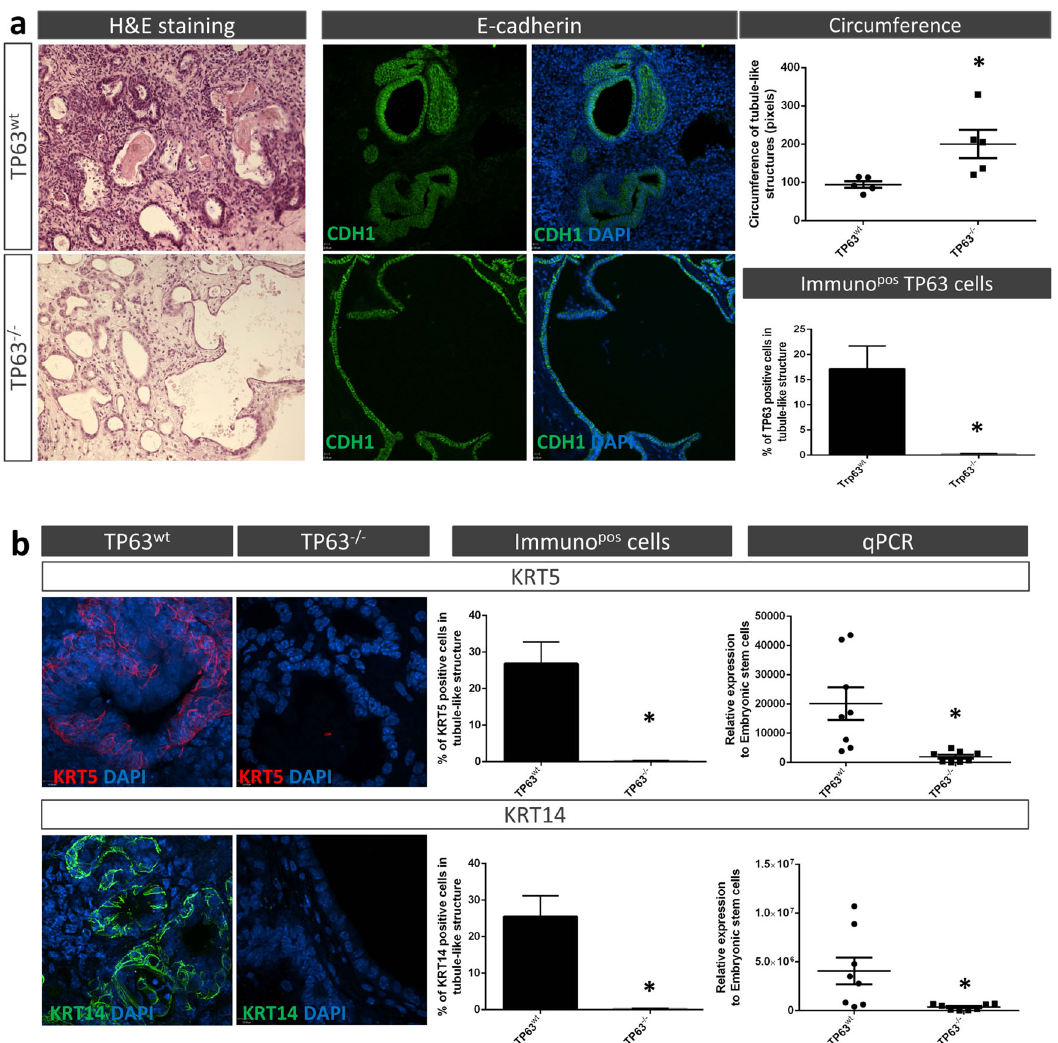
Fig. 4 TP63-de fi cient de fi nitive endoderm (DE) cells seeded on decellularized lung scaffolds do not differentiate into basal cells. a DE cells seeded on acellular lung scaffolds after 21 days of culture form tubule-like structures (left panels) that are lined with CDH1 + epithelial cells (middle panels). Loss of TP63 leads to larger tubule-like structures (a-top right panel) devoid of TP63 + cells (bottom right panel). Data are expressed as mean ± SEM, n ≥ 12 different scaffolds, * p < 0.05. b -left panel Representative immuno fl uorescence confocal images and quanti fi cation of KRT5 + and KRT14 + epithelial cells in tubule-like structures of wildtype and TP63 − / − DE cells seeded on acellular lung scaffolds (mean ± SEM, n ≥ 16 different scaffolds, * p < 0.05). b -right panel Quantitative PCR of Krt5 and Krt14 gene expression in wildtype and TP63 − / − DE cells seeded on acellular lung scaffolds (mean ± SEM, n = 8 separate scaffold cultures, * p <